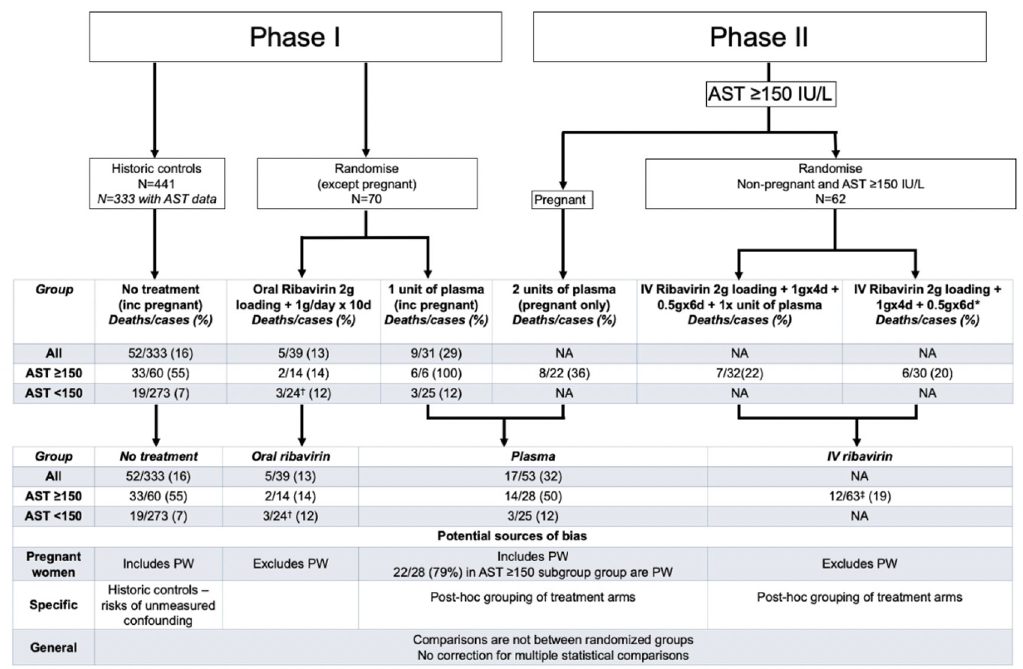
Fig 1. Reconstruction of the McCormick et al. data. A AU : AbbreviationlistshavebeencompiledforthoseusedthroughoutFigs 1 and 2 : Pleaseverifythatallentriesarecorrect : ST, aspartate aminotransferase; PW, pregnant women.† Discrepancy within McCormick et al, with 39 patients reported treated with oral ribavirin but only 38 (14+24) outcomes reported. ‡ Discrepancy within McCormick et al, with table 1 reporting 12/63 but text reporting 13/62.